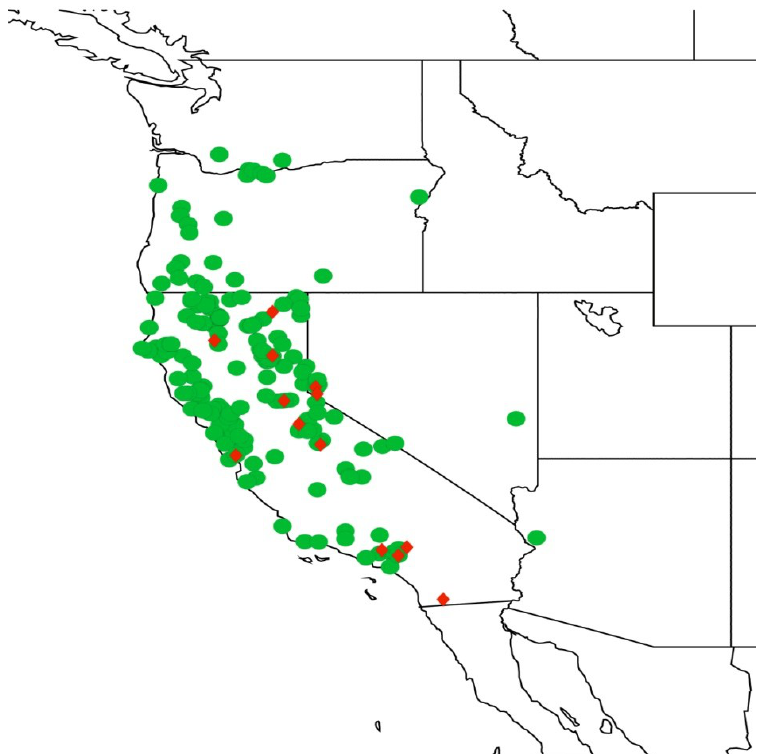
Figure 51. Distribution of Okanagana tristis tristis (green circles) and O. tristis rubrobasalis (red